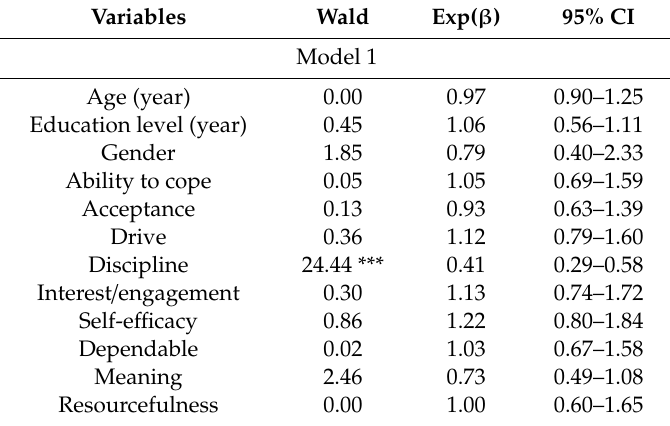
Table 4. Logistic regression model of Internet gaming disorder for items of 14-Item Resilience Scale with controlling for gender, age, and education